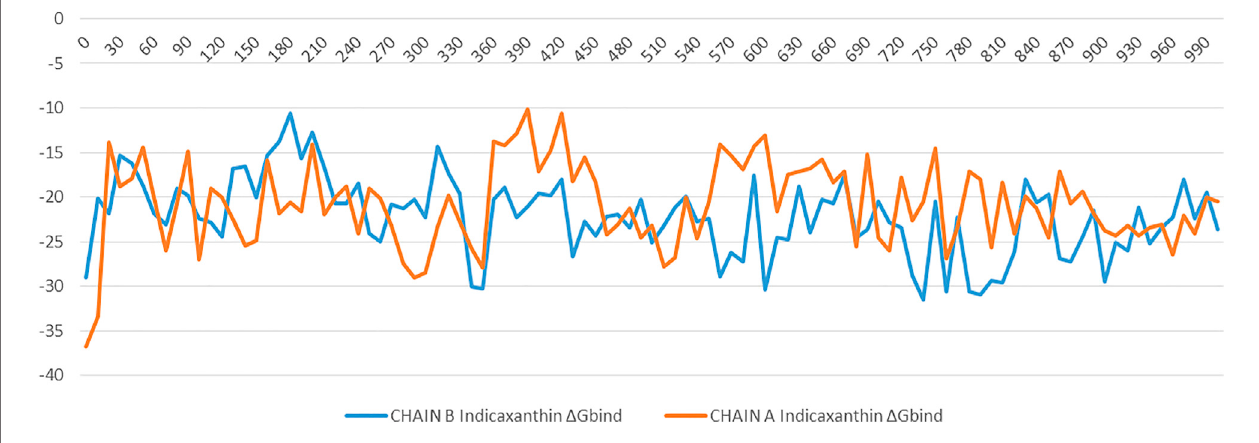
FIGURE 10 | The binding energy ( Δ G expressed in kcal/mol) landscape of Indicacaxanthin bound to Chain A and Chain